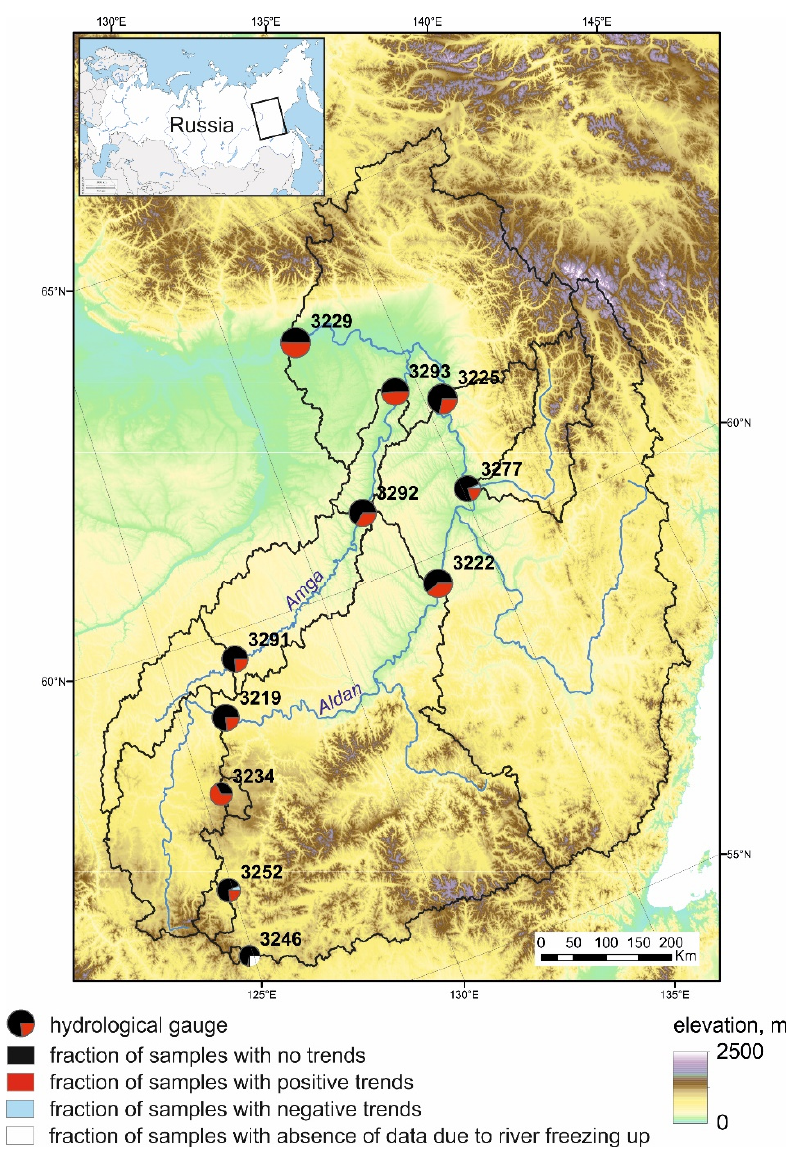
Figure 1. Scheme of the studied area: Aldan river basin and analyzed subbasins, fraction of the samples with positive, negative, no trends and no data. Size of the circles is proportional to the basin area.